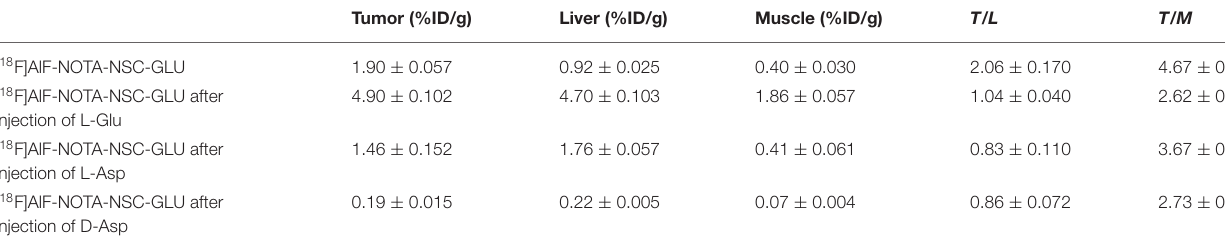
TABLE 2 | The data of uptake in organs of interest in competitive binding in vivo .